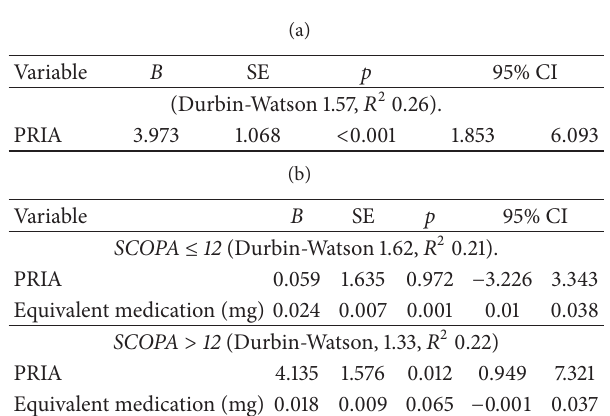
Table 4: (a) General linear regression model examining the effect of PRI affective on life quality (PDQ-39SV) in Parkinson’s disease patients. (b) Linear regression models examining the effect of PRI affective on life quality (PDQ-39SV) in low and high SCOPA Parkinson’s disease patients.